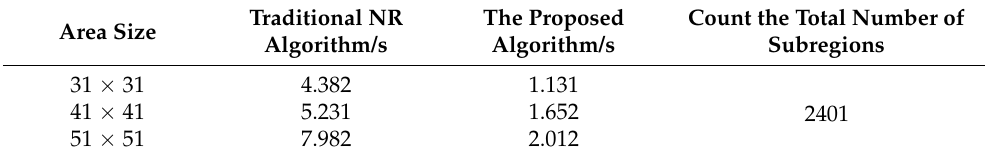
Table 1. Comparison of calculation